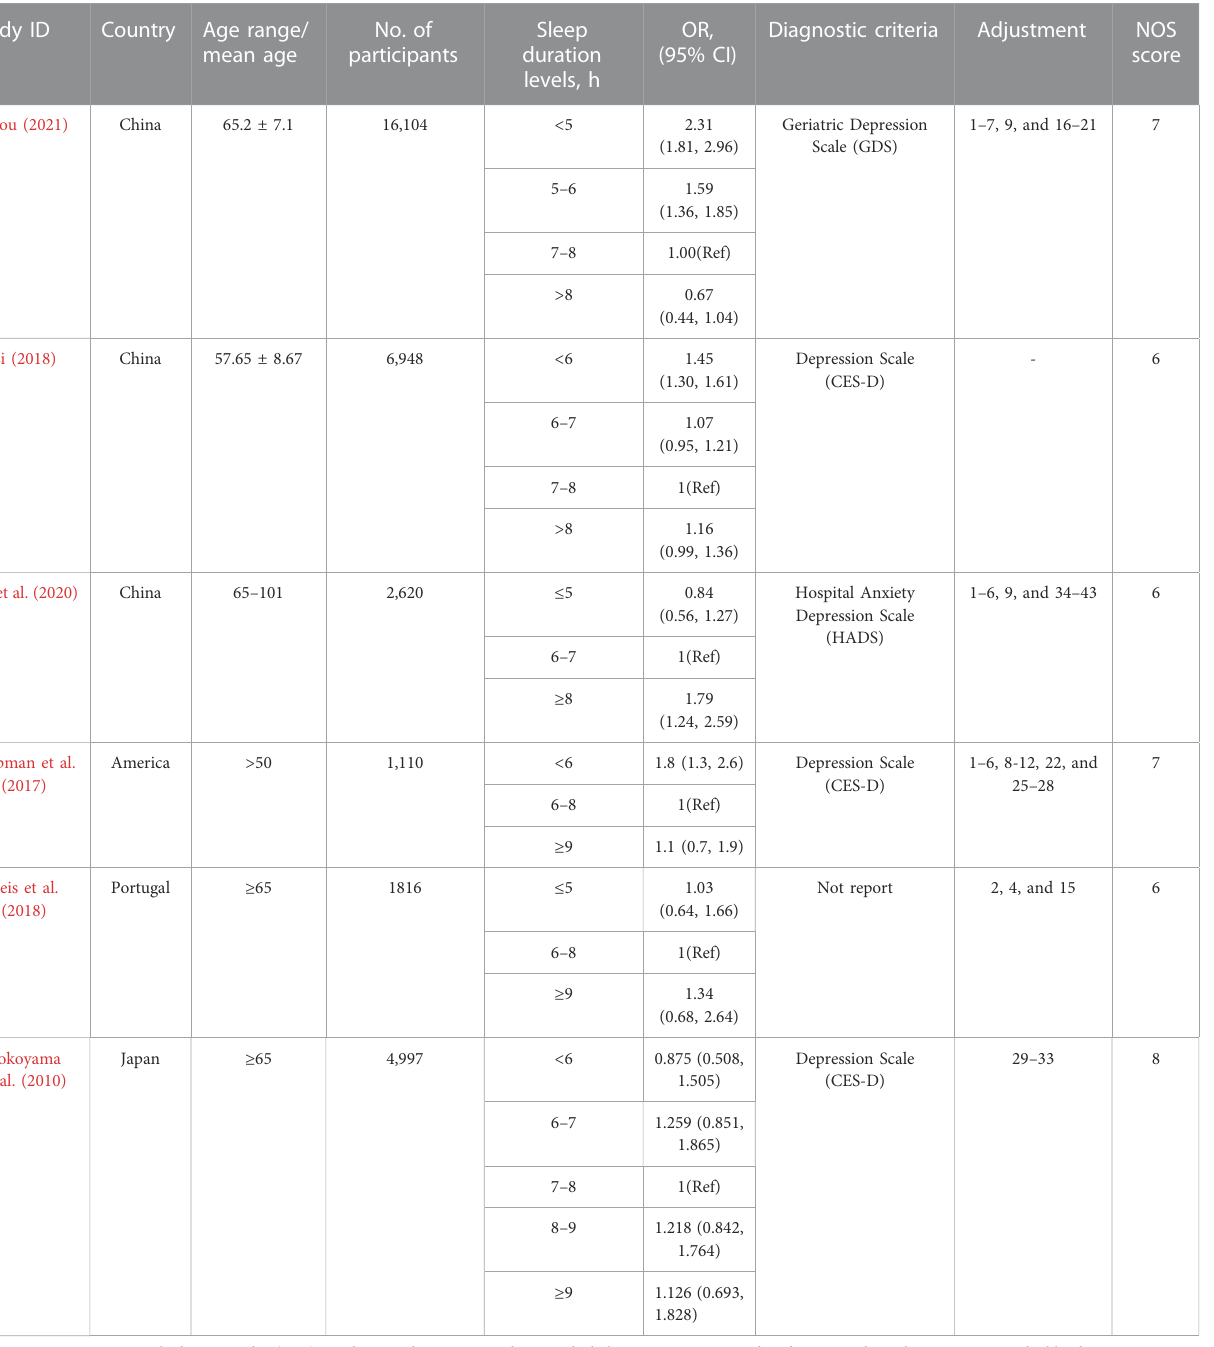
TABLE 1 Characteristics of included